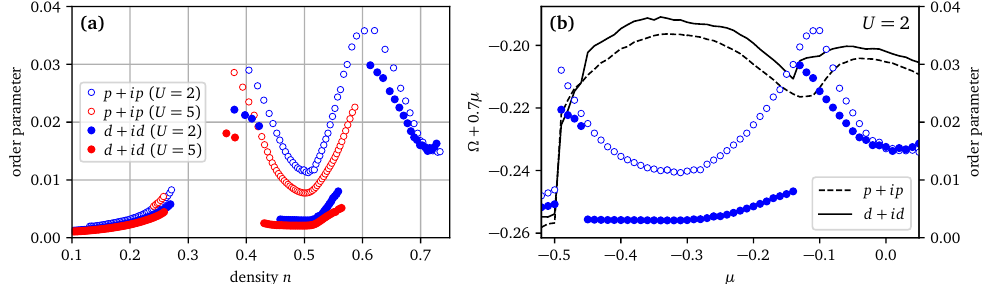
Figure 5: Left panel: d + id order parameter found by CDMFT (filled circles), as a function of electron density n , compared with the p + ip order parameter (open circles), for U = 2 meV and U = 5 meV. The d + id order parameter is the ground state average of the operator (2b), restricted to the cluster. Again, clusters on the second layer would show the opposite chirality ( d − id ). Right panel: For U = 2 and as a function of chemical potential µ , the same chiral order parameters as in the left panel, as well as the value of the Potthoff functional Ω for each solution. The p + ip solution (dashed curve) has a lower energy than the d + id solution (full curve). A multiple of µ was added to Ω to rectify the curves and improve